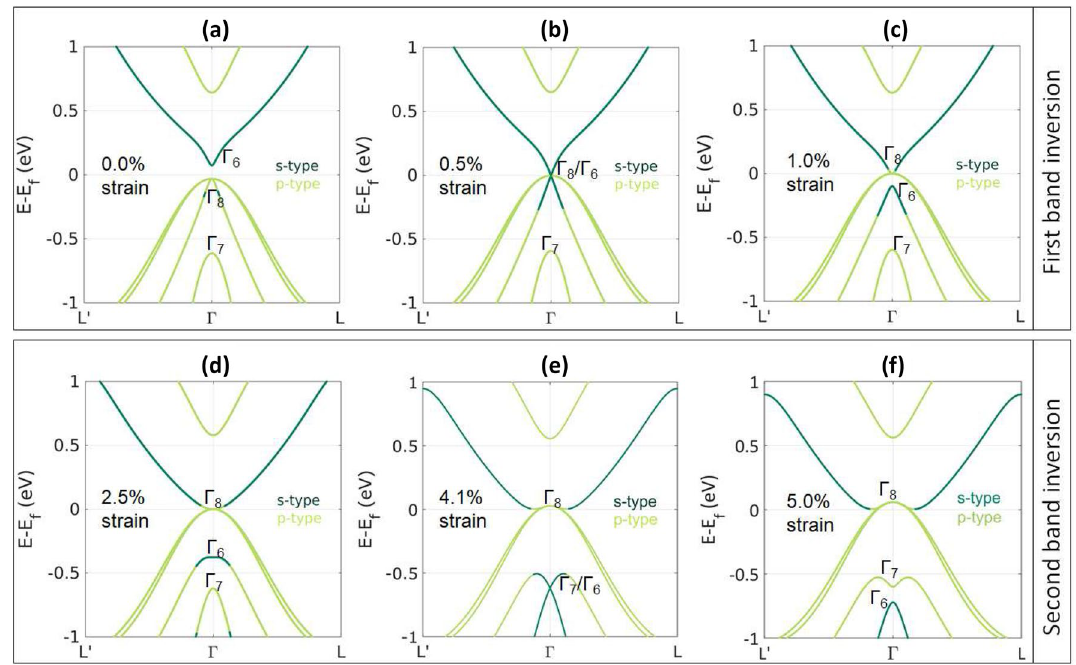
Figure 2. Electronic band-structure of YPdBi under uniform tensile strain showing two band inversions. Dark green and light green colors represent s type and p type bands